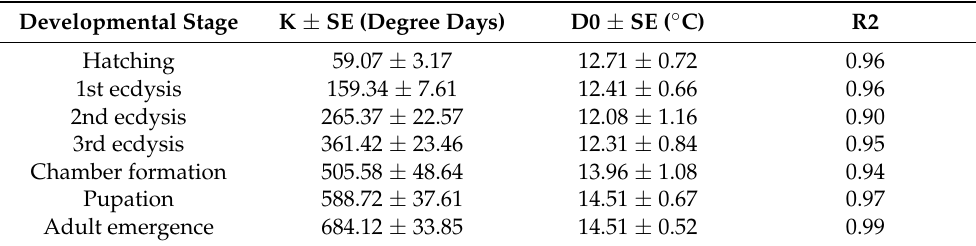
Table 2. Developmental threshold temperatures (D 0 ) and thermal summation constants (K) for different development stages. The coefficient of determination (R 2 ) of thermal summation models was calculated according to the method described by Ikemoto and Takai [45].